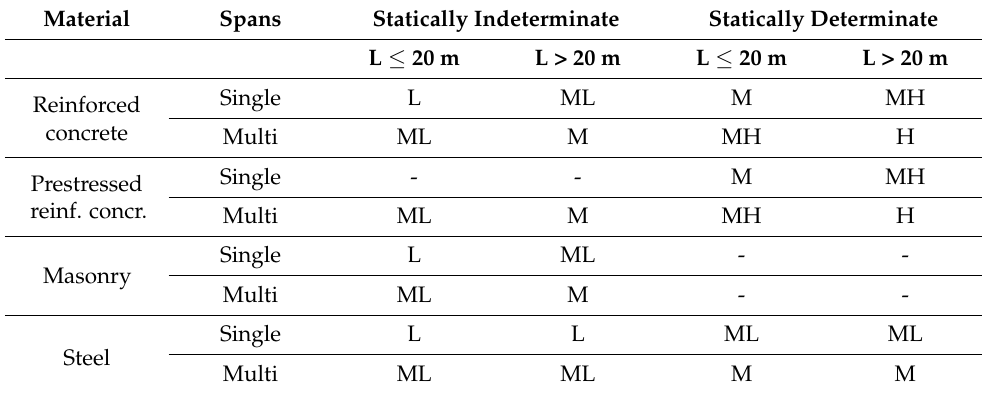
Table 2. Primary vulnerability based on the vulnerability primary parameters.